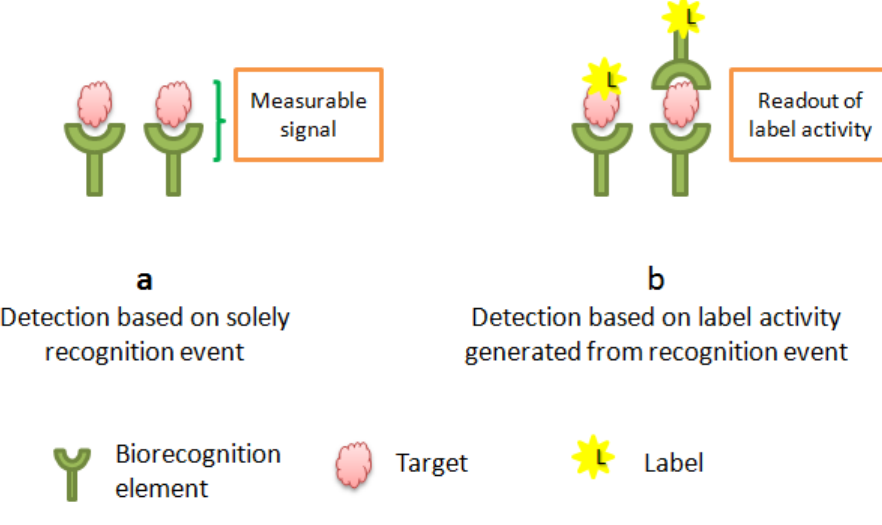
Figure 1. Label free ( a ) vs. label dependent biosensors ( b ).